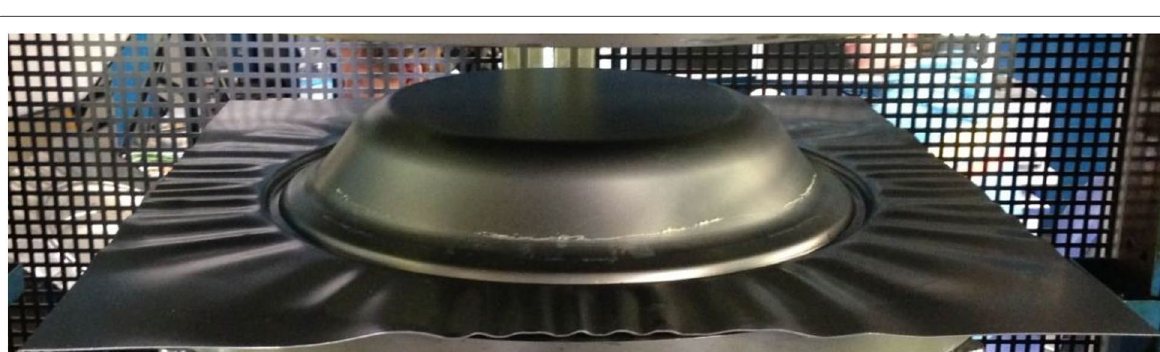
0.000.050.100.15